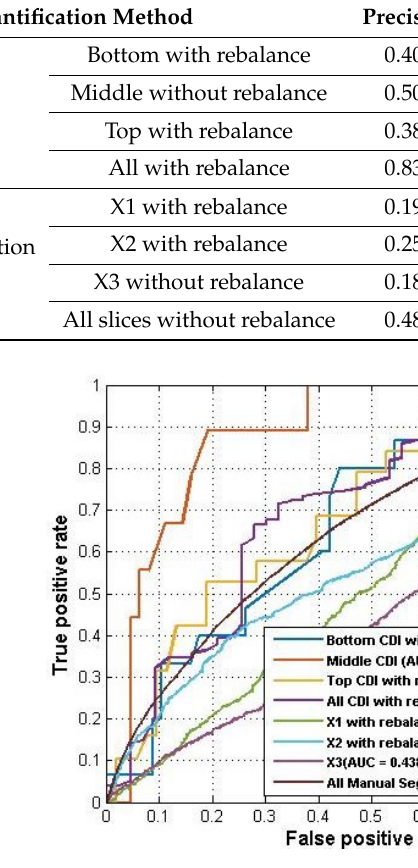
Figure 7. ROC of CDI and all manual segmentation slices. Table 10. Comparison of the performance of ANN with ZeroR using the whole medial